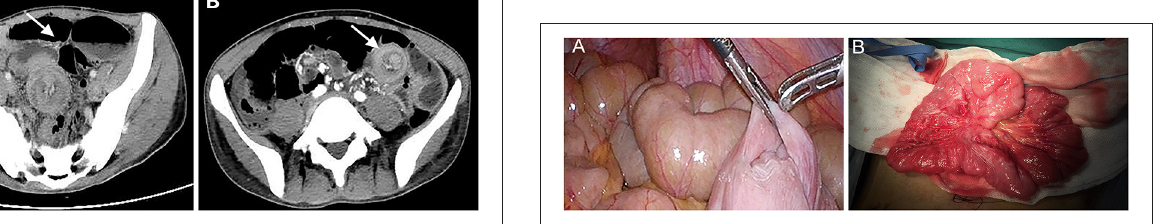
Frontiers in Surgery |